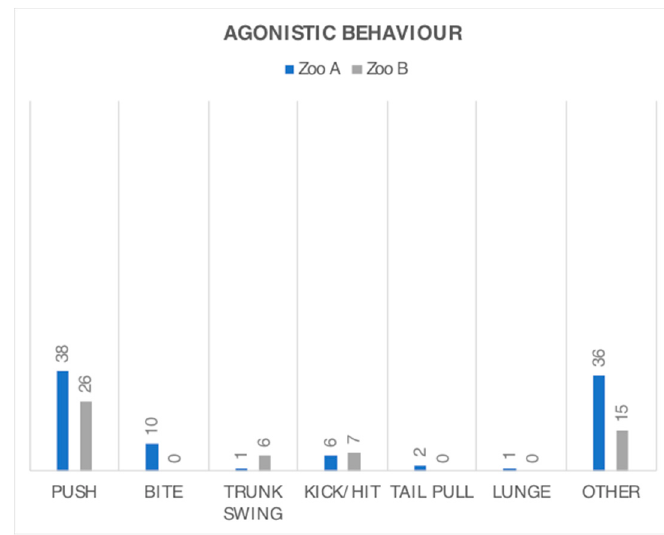
Figure 4. Frequency of observed agonistic interactions between the female elephants at Zoo A and B. Data from combined spring and autumn observations are given in terms of raw frequencies and presented on the same scale as Figure 3.